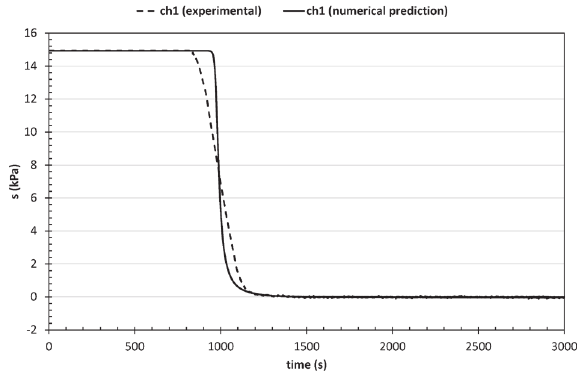
Figure 11: Comparison between measured and predicted variation of suction with time at